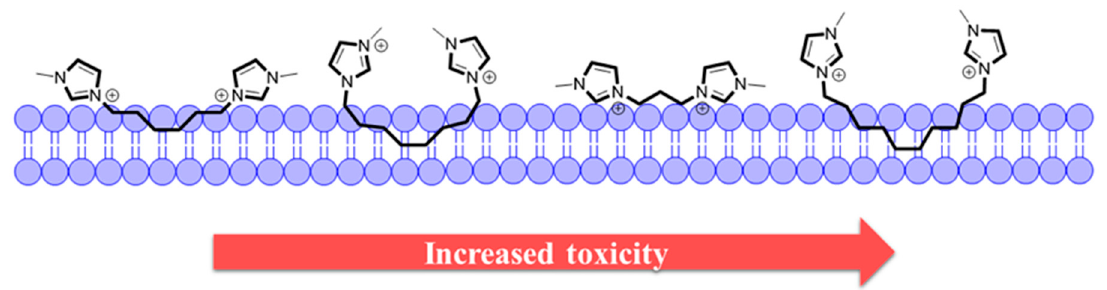
Figure 3. Interaction of DILs with the lipid bilayer by anchoring ([C n (MIM) 2 ] 2+ , n = 4, 6, 8, 10. Anions have been omitted for better representation).